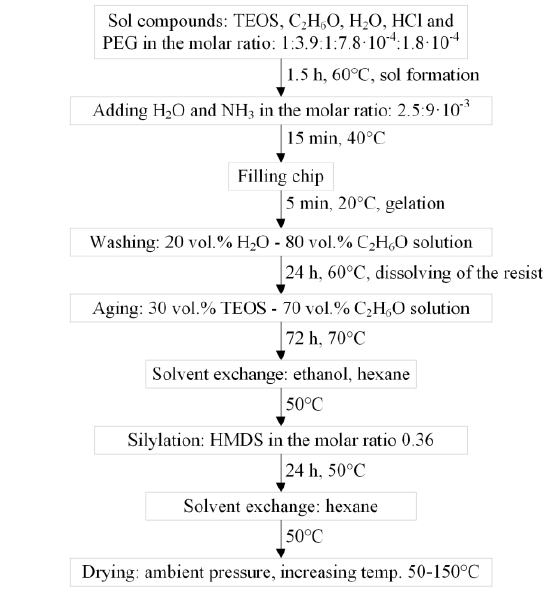
Figure 2. Experimental procedure including an acid-base sol-gel process. Operating temperatures and duration of the single steps are